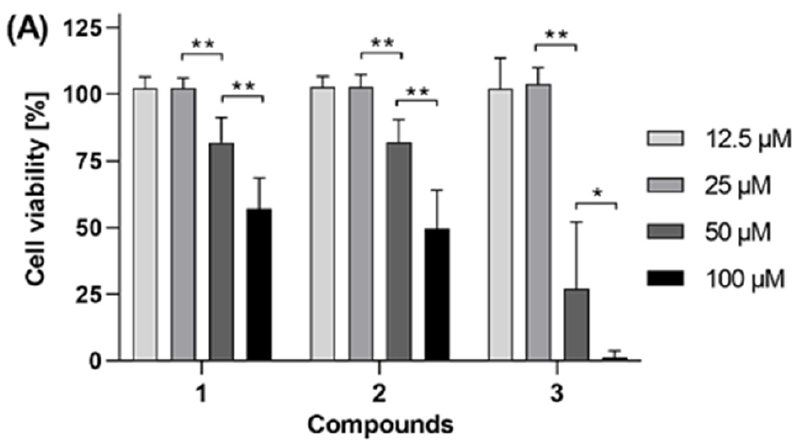
Table 1. Anthelmintic activity against parasitic organisms. Organism NTS ** (100 µ